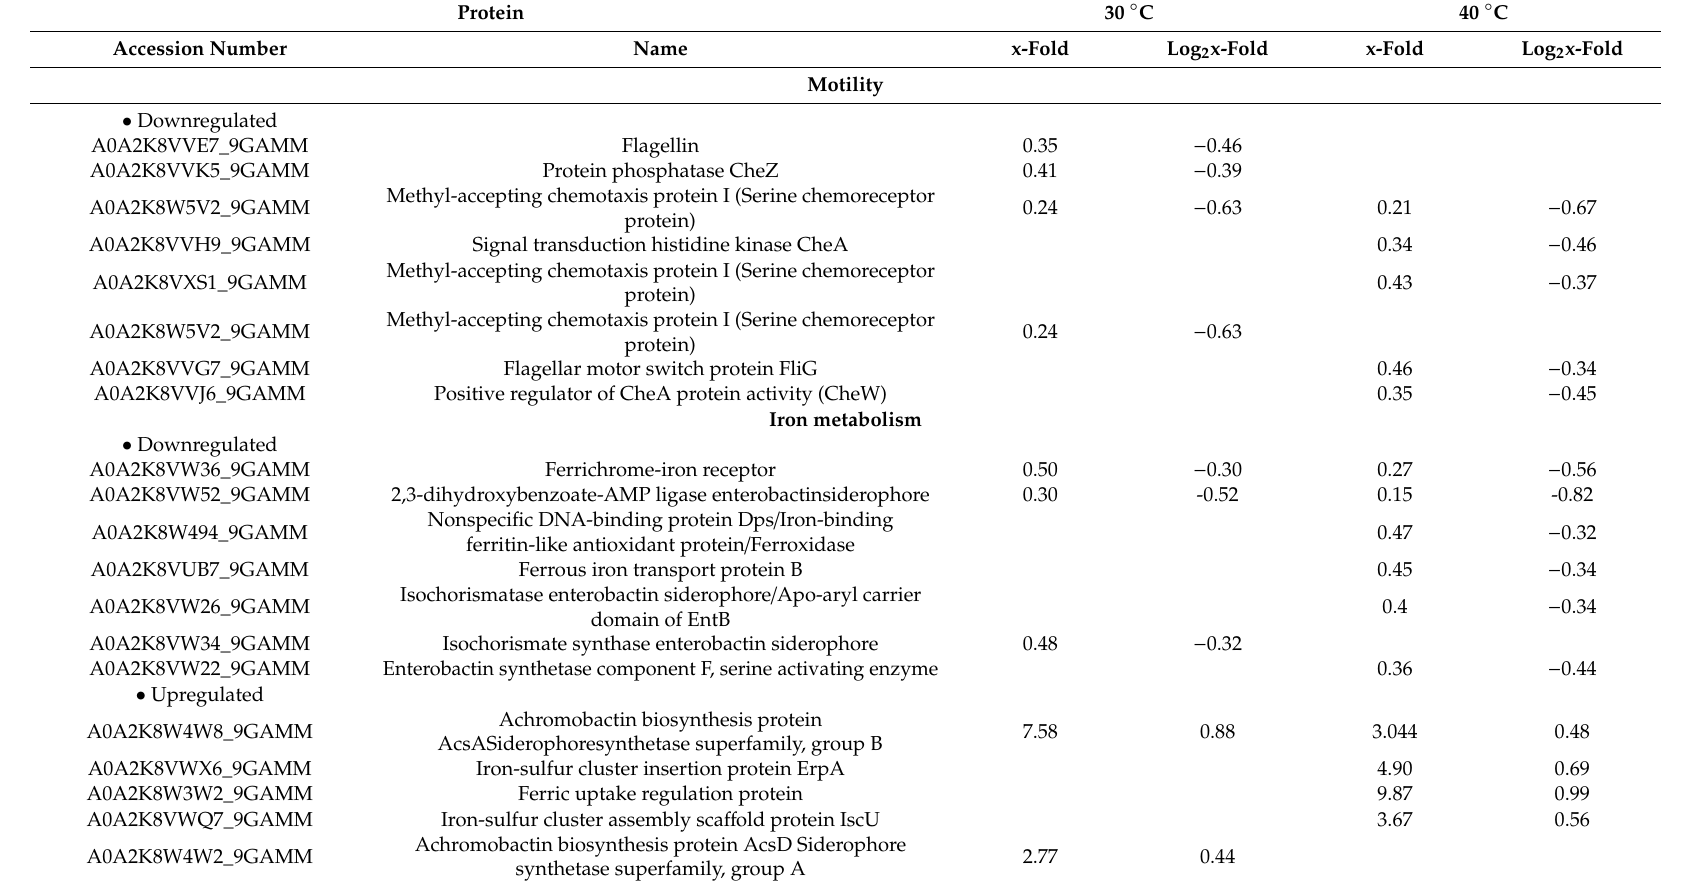
Table 1. Summary of proteins whose level depends on Lon